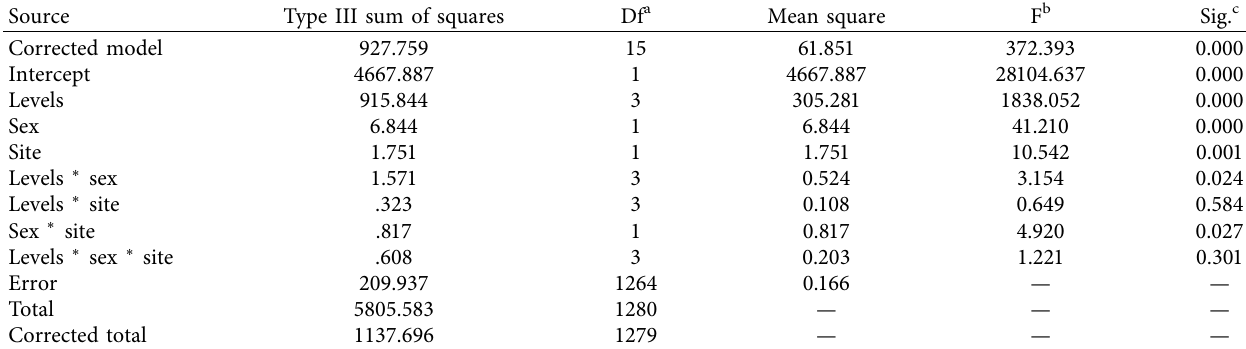
Table 2: Three-way ANOVA test of between-subject effects {level of measurements, sex, and site of measurement (buccal or